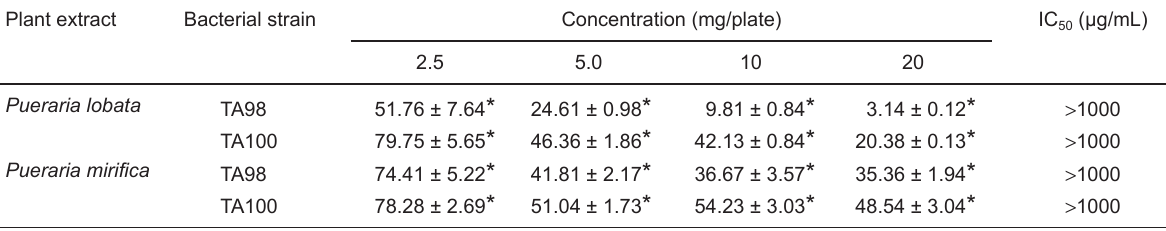
Table 1. Survival (cytotoxicity) test of the plant extracts on Ames test Salmonella typhimurium indicator strains TA98 and TA100. Plant